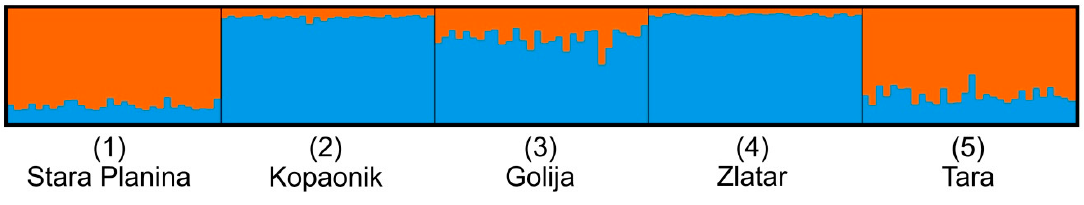
Figure 2. Results from structure analysis of Norway spruce populations when K = 2.